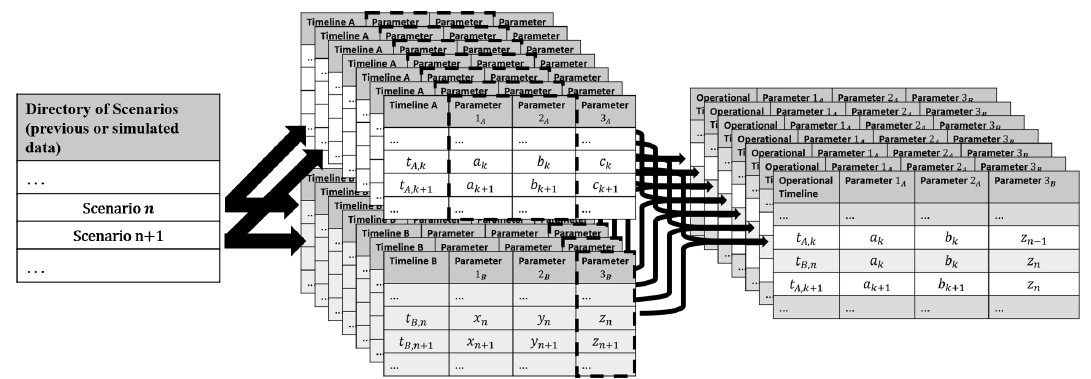
Figure 6. Data from different models with varying time frequencies are compiled into a single operational timeline. Given multiple accident scenarios, this produces many example operational timelines, which can be used for constructing the DBN’s conditional probability tables.